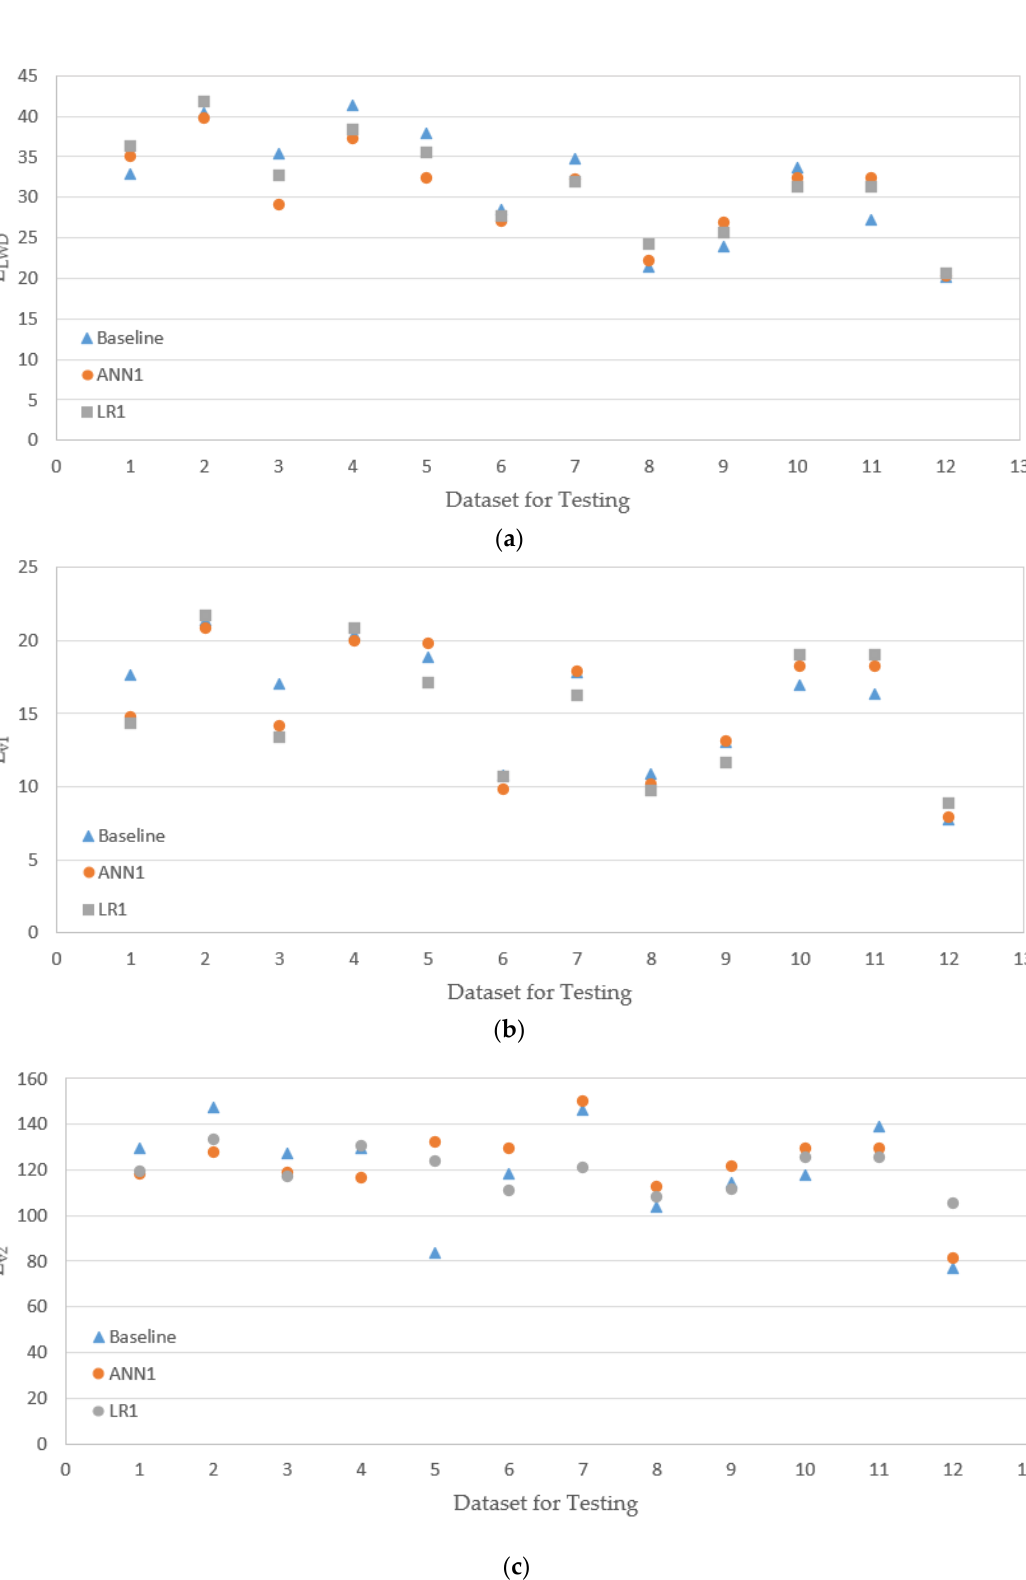
( a ) ( b ) Figure 14. Testing results 2 (results of ANN are based on the model ANN2, and results of LN are based on the model LN2). ( a ) Testing results from E v1 ; ( b ) testing results from E v2 .